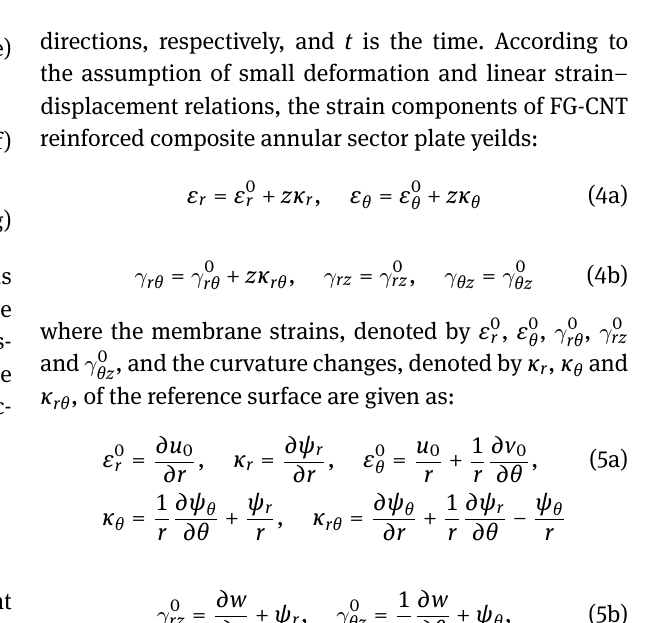
Figure 2: Distribution types of CNTs of FG-CNT reinforced composite annular sector